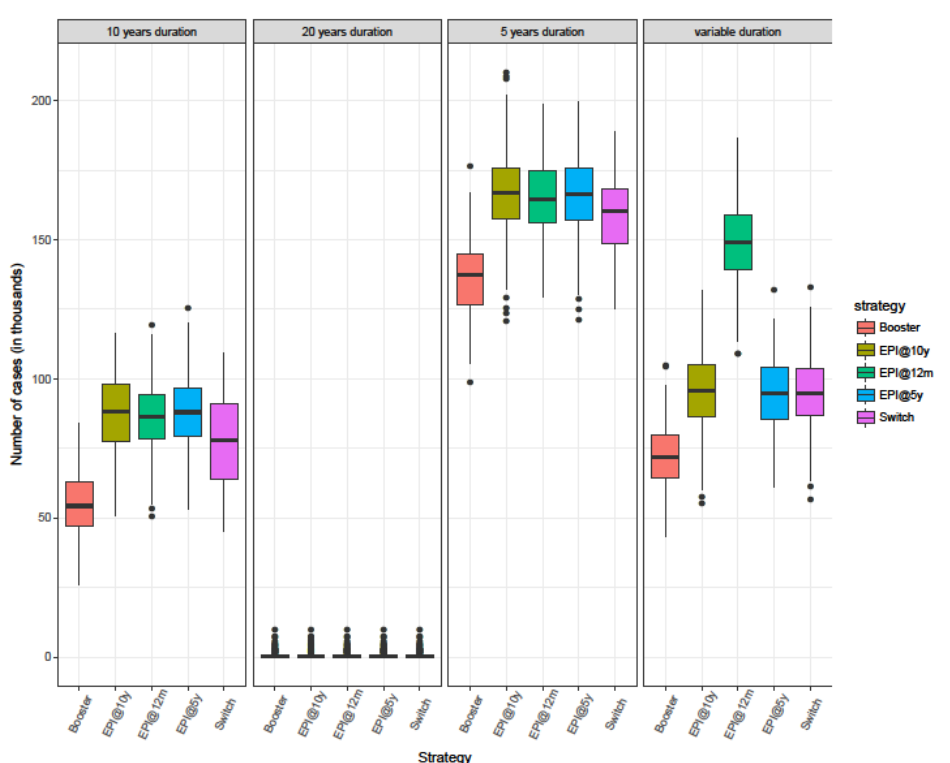
Figure 2. Total number of cases plotted against the year of resurgence across all scenarios and all assumptions regarding duration of protection and coverage. Each strategy is represented with a different colour and each assumption about the duration of protection is represented with a differ- ent symbol shape. Note that 20 years duration of protection is not shown. Error bars show the 95% confidence interval.